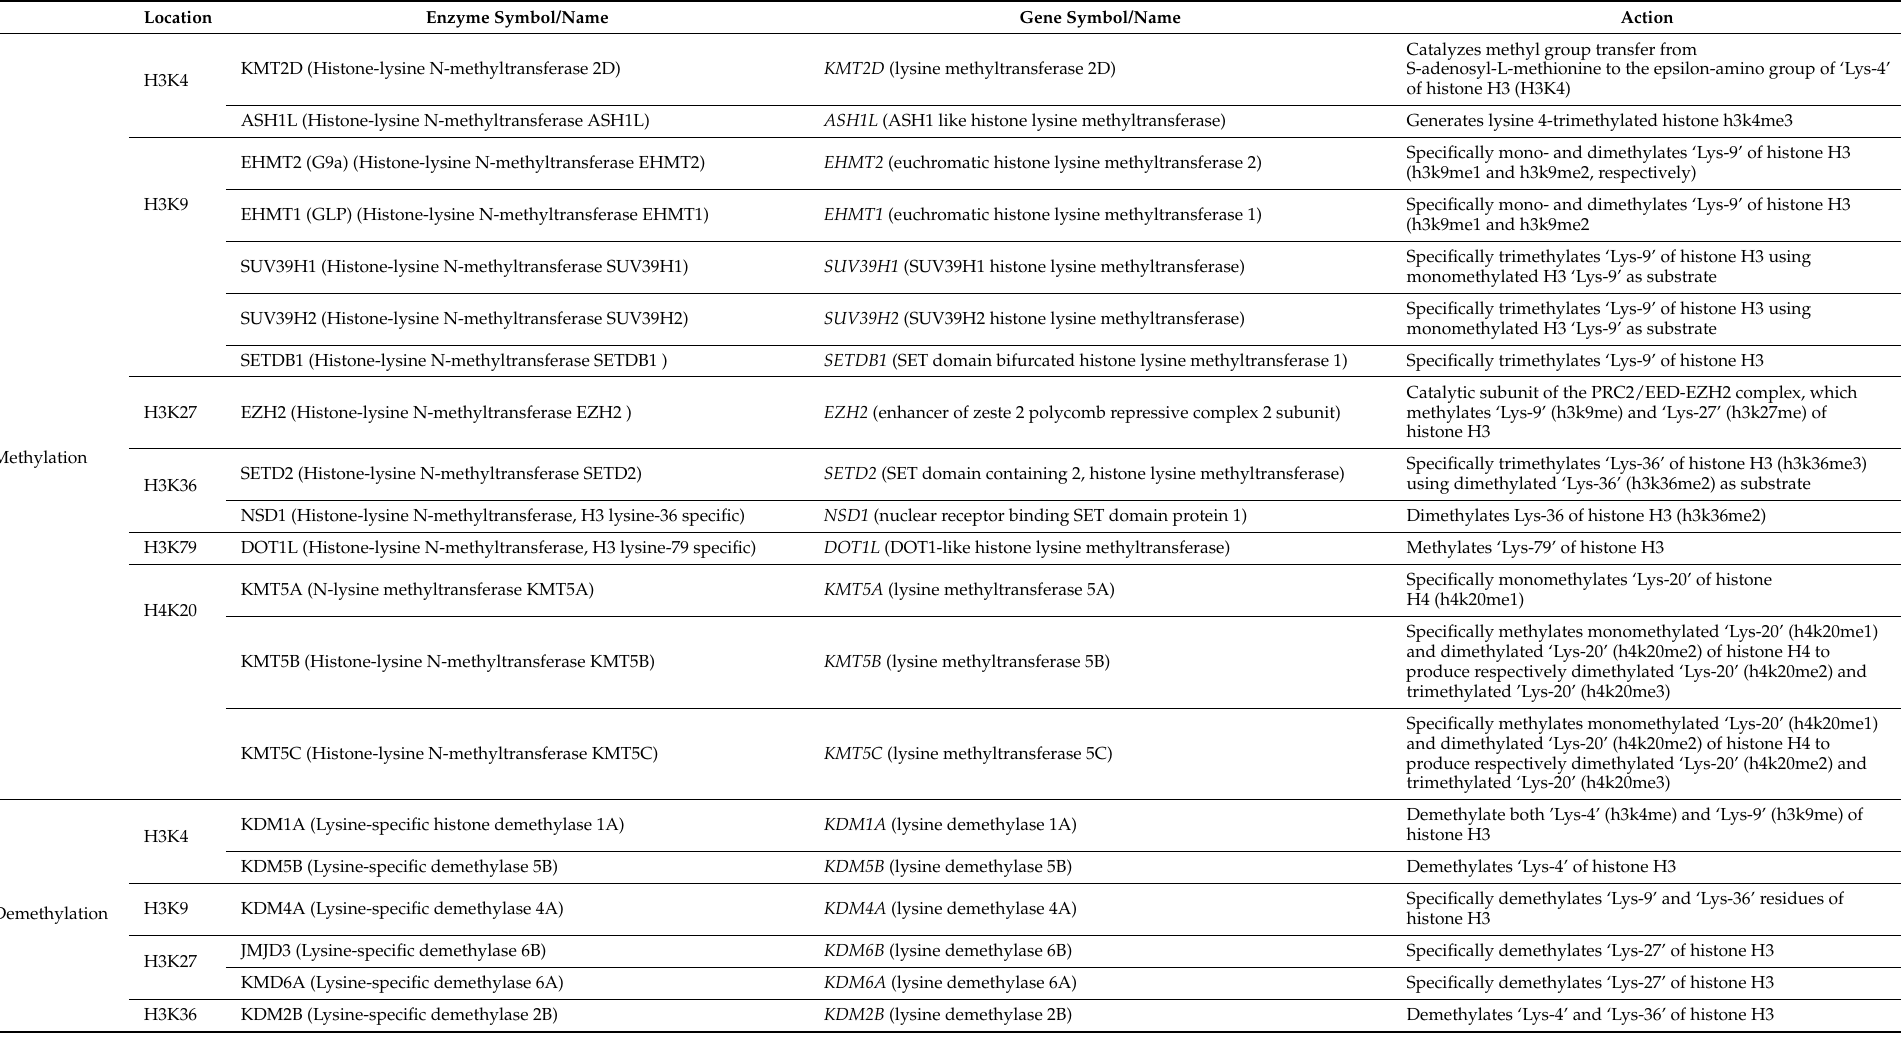
Table 3. Main methyltransferases and histone demethylases and their actions